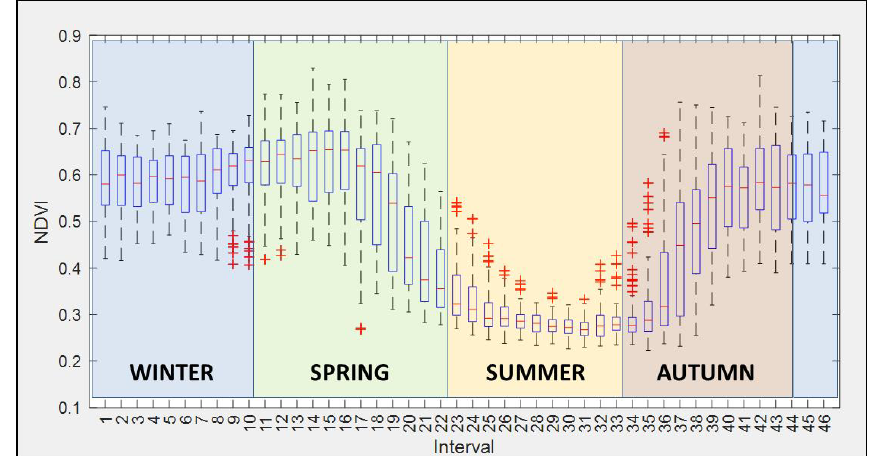
Figure 4. Box plots of 46 random variables (RVs) are shown as well as the start and end reference of every season. The study period ranges from 2002 to 2017.